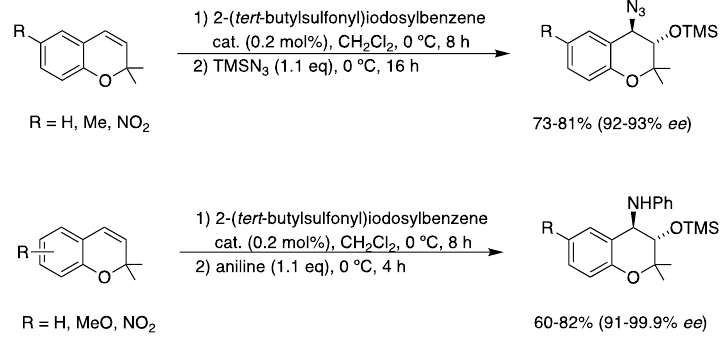
Scheme 7. The sequential asymmetric epoxidation / ring-opening of 2,2-dimethyl-2 H -chromenes catalyzed by the mixed Mn–Cr coordination cage shown in Figure 12.